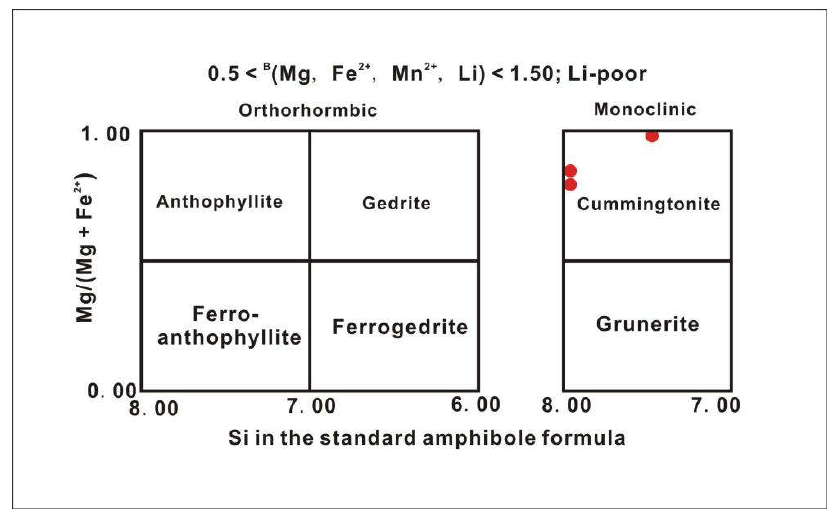
Figure 6. Diagram for classification and nomenclature of amphibole series with Ca.